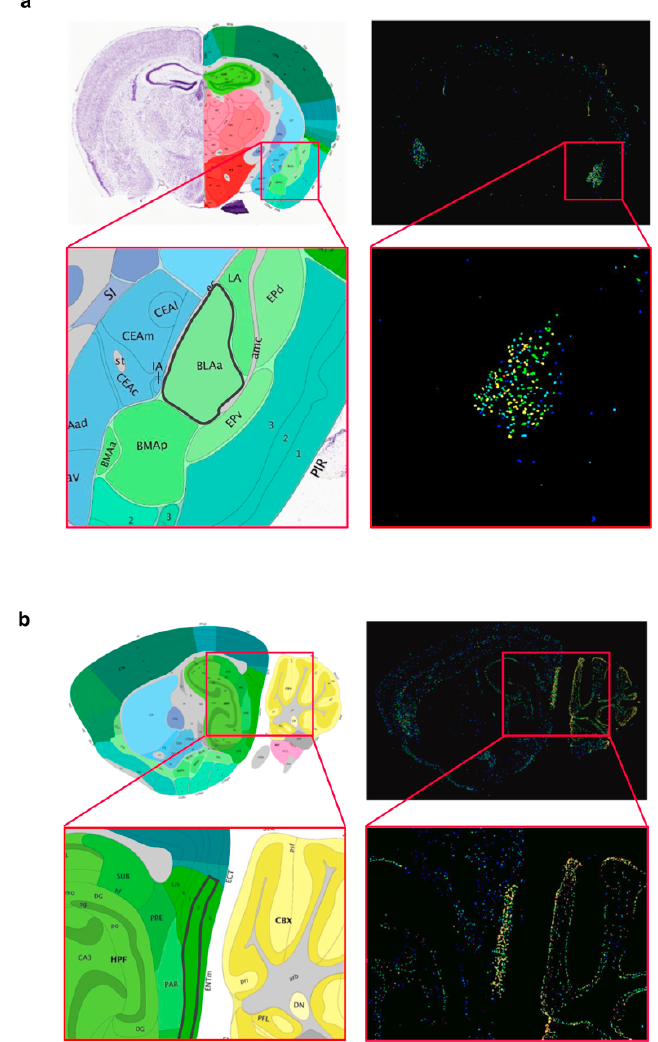
Figure 2. Localized Wwox expression in basolateral amygdala and medial entorhinal cortex of mouse brain. ( a ) Coronal brain section showing Wwox mRNA in-situ hybridization signals clearly delineating the anterior (BLAa) region of the basolateral amigdalar nucleus in the cortical subplate. The inset shows the zoomed image of the BLAa region, highlighted with a black border in the annotated panel (left). ( b ) Sagittal section showing in situ hybridization signals, specifically lighting-up layer 2 of the medial entorhinal cortex (ENTm2, medial part, dorsal zone, layer 2). The inset shows the zoomed image of the ENTm2 region, highlighted with a black border in the annotated panel (left). It can also be observed that Wwox expression clearly delineates specific layers of the cerebellar cortex. Brain tissue sections from 56-day old, C57Bl/6J male mouse. All images were obtained from the Allen Mouse Brain Atlas—Allen Institute (https://mouse.brain-map.org/) [19].